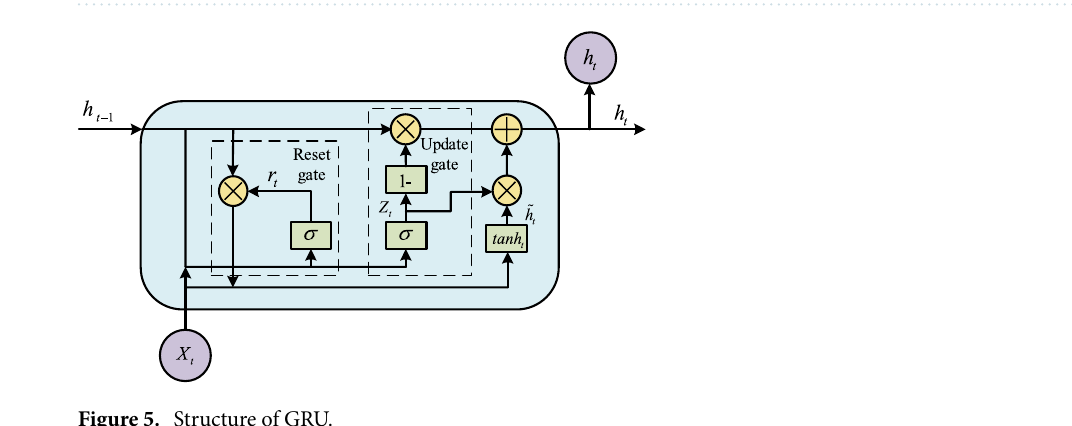
Figure 4. Proposed malicious traffic detection structure.